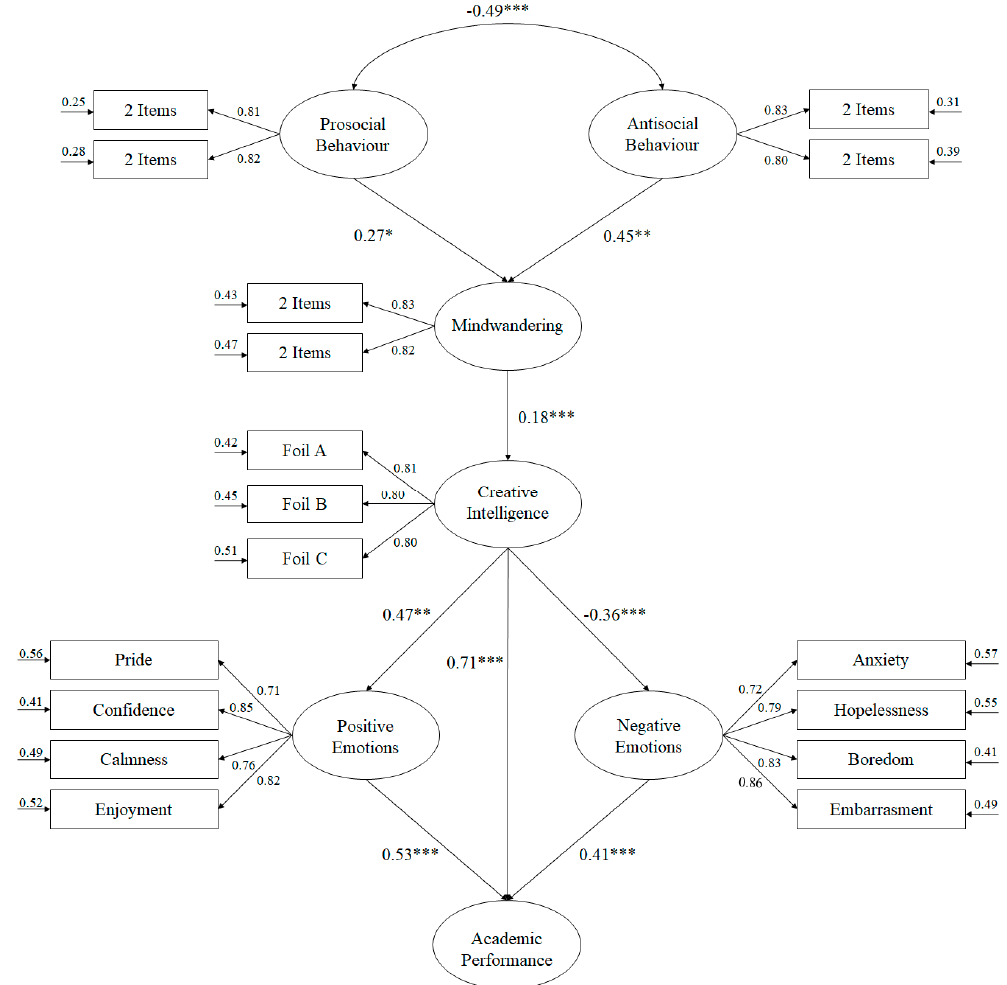
Figure 1. Structural equation model showing the relationships between the various factors that make up the study. All parameters are standardized and statistically significant. Note: *** p < 0.001; ** p < 0.01; * p < 0.05.